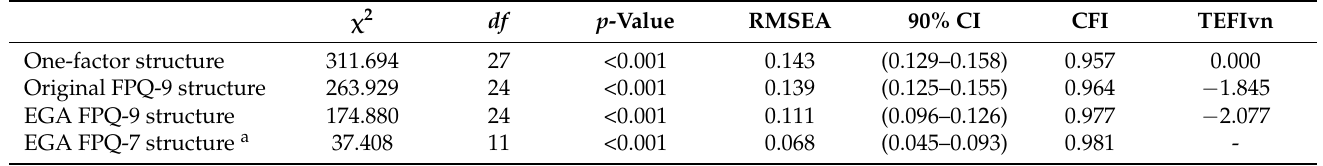
Table 2. Model fit comparison of the original FPQ structure and EGA identified dimensions.